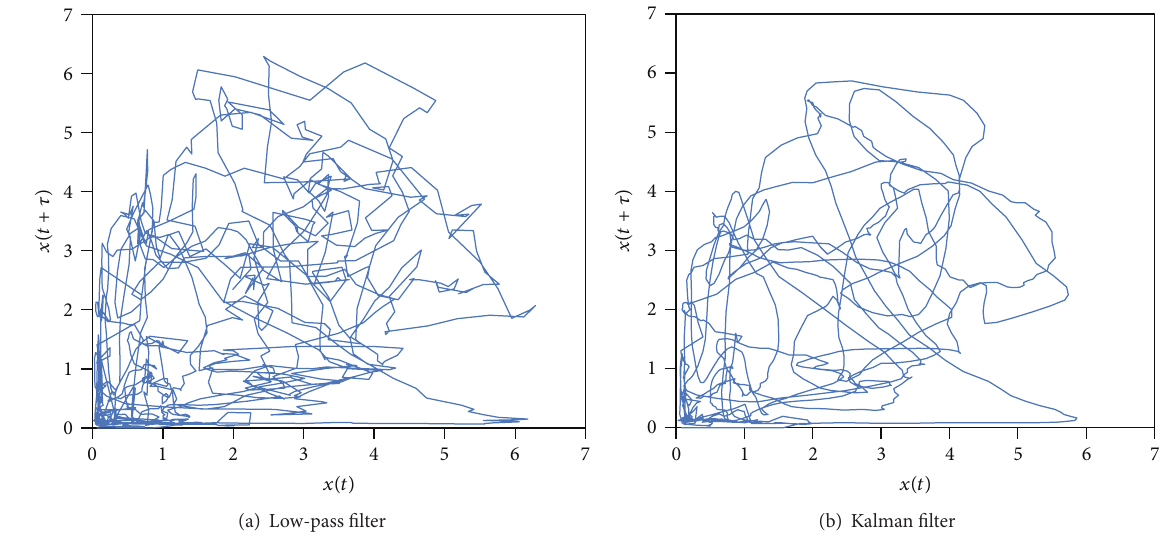
Figure 7: The attractors of noise removed radar rainfall series by LF and KF. Table 4: The BDS statistic values for radar rainfall and the noise removed series. Radar rainfall Low-pass filter Kalman filter 95%